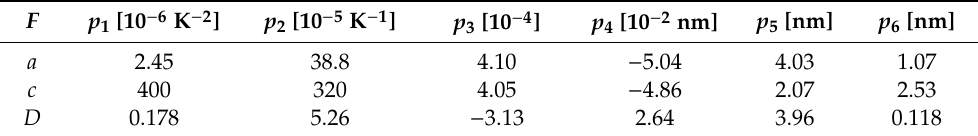
(cid:16) (cid:17) (cid:16) (cid:17) · + p + p + p + p p 1 T 2 p 4 c 2 ; 2 T D 3 5 c Ge 6 D Ge